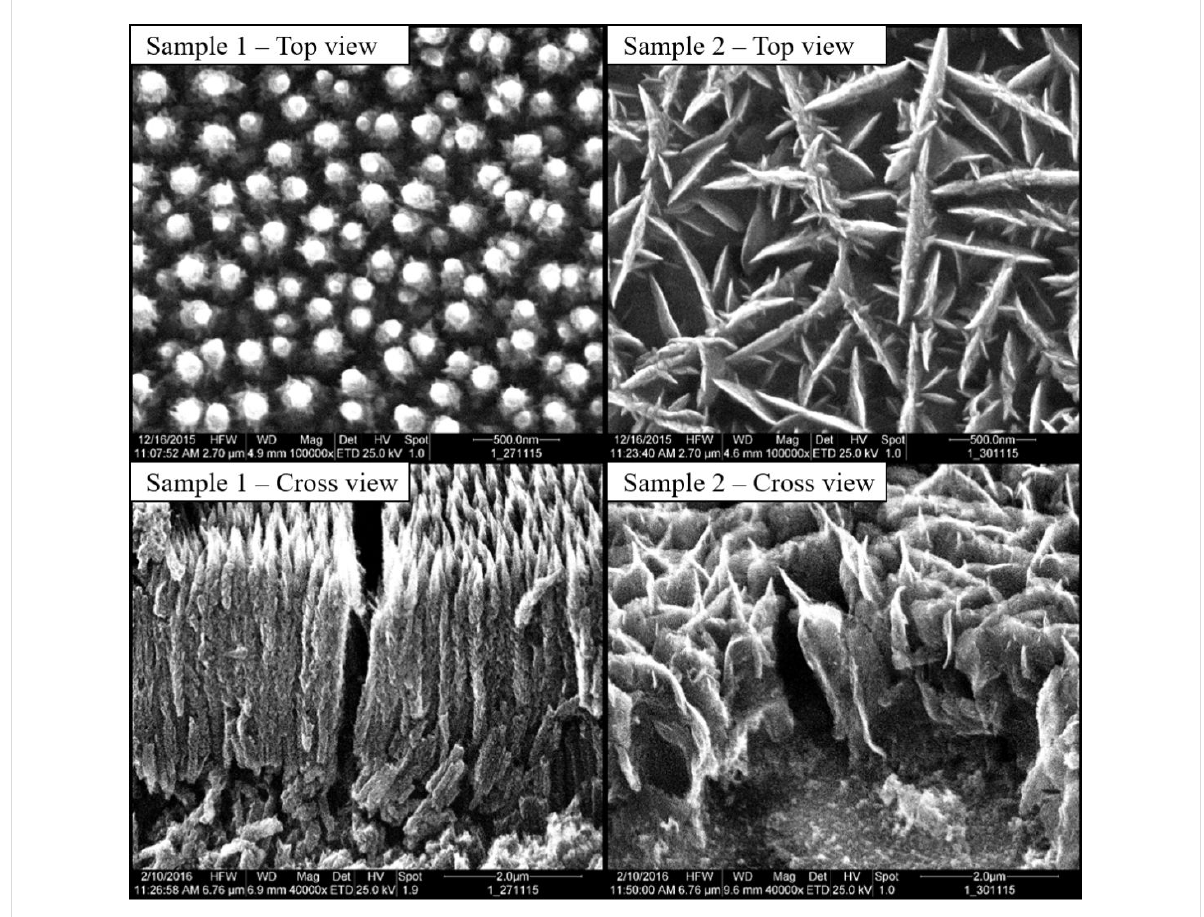
Figure 3: SEM images. Sampe 1 deposited at 350 °C and 0 V bias voltage: nanorods; sample 2 deposited at 350 °C and − 10 V bias voltage: thorny CNWs. All grown on stainless steel substrates. Cross-section images taken under from an angle of 45°.